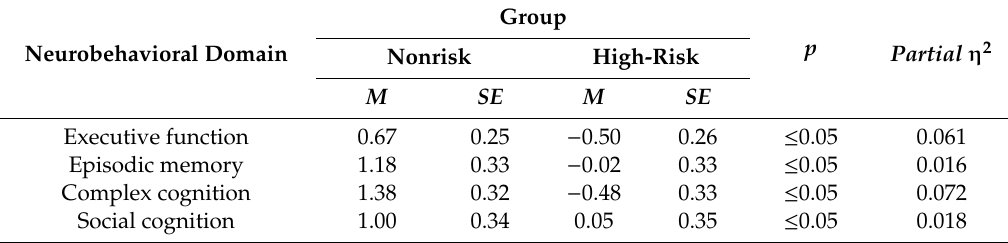
Table 4. E ffi ciency neurocognitive performance scores by